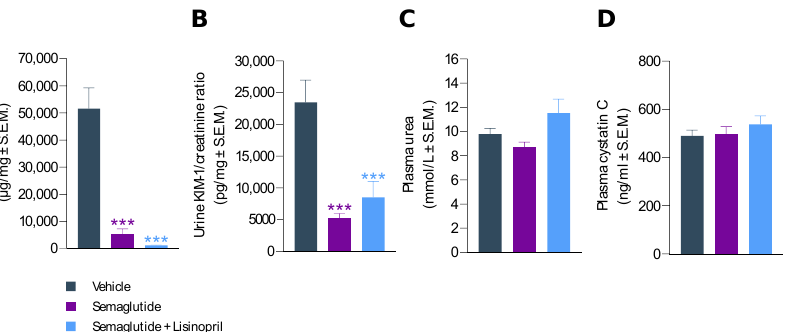
Figure 4. Semaglutide improves urinary markers in db / db UNx-ReninAAV mice. ( A ) Urine albumin- to-creatine ratio (ACR). ( B ) Urine kidney molecule-1 (KIM-1)-to-creatine ratio. ( C ) Plasma urea concentrations. ( D ) Plasma cystatin C levels. Semaglutide monotherapy (30 nmol/kg, s.c, q.d., n = 15) and combination treatment with lisinopril (30 mg/kg, p.o., q.d., n = 14) was performed for 11 weeks in db / db UNx-ReninAAV mice. Vehicle-dosed (s.c, q.d.) db / db UNx-ReninAAV mice ( n = 15) served as controls. *** p < 0.001 vs. vehicle-dosed db / db UNx-ReninAAV mice (Dunnett’s test one-factor linear model with interaction).